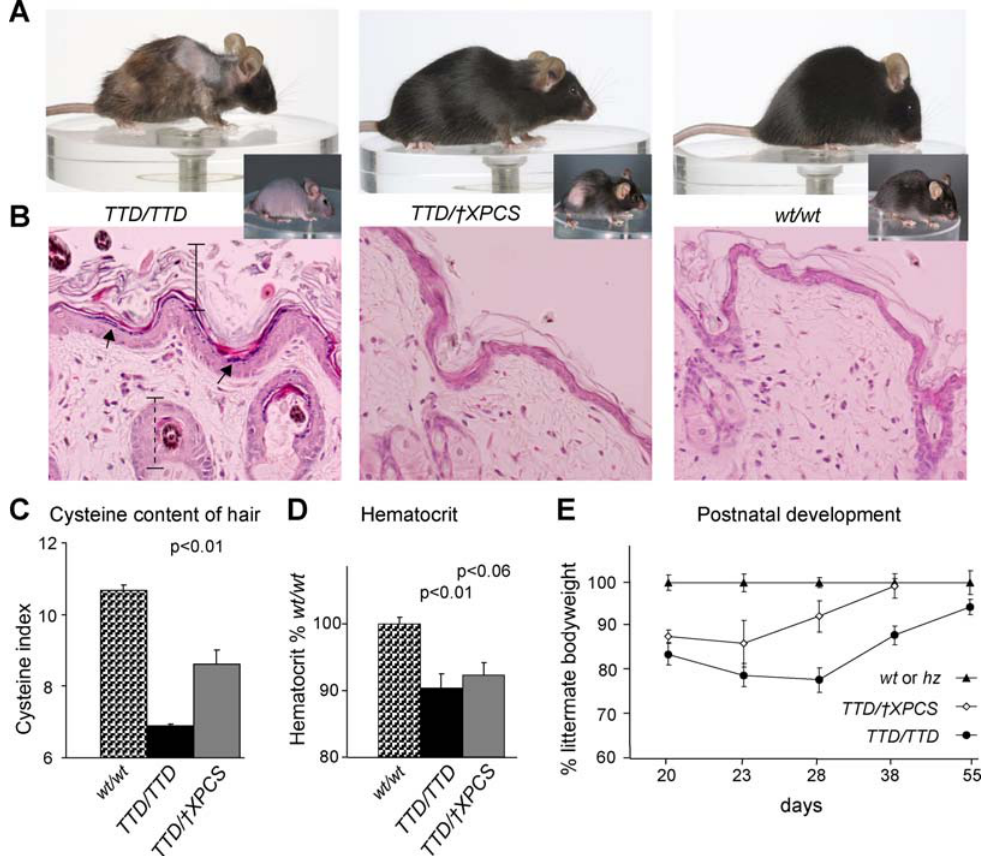
Figure 2. Partial Rescue of TTD Cutaneous, Blood, and Developmental Phenotypes in Compound Heterozygous Xpd TTD/ (cid:1) XPCS Mice (A) Photographs of 5-mo-old homozygous Xpd TTD/TTD , compound heterozygous Xpd TTD/ (cid:1) XPCS, and wt mice. Insets: images of first-round hair loss. (B) Histological analysis of the skin of Xpd TTD/TTD , Xpd TTD/ (cid:1) XPCS, and wt mice. TTD-associated acanthosis (thicker epidermis, indicated by solid vertical line), pronounced granular layer (indicated by arrows), and sebacious gland hyperplasia (indicated by dotted vertical line) were absent in the epidermis of Xpd TTD/ (cid:1) XPCS and wt mice. Magnification 400 3 . (C) Cysteine content of hair from wt, Xpd TTD/TTD , and Xpd TTD/ (cid:1) XPCS mice. The p -value indicates significant differences between mutants and wt, as well as between Xpd TTD/TTD and Xpd TTD/ (cid:1) XPCS mice. Error bars indicate standard error of the mean (SEM). (D) Hematocrit values from blood of Xpd TTD/TTD and Xpd TTD/ (cid:1) XPCS mice. The p -values indicate the significance of the difference relative to wt. Error bars indicate SEM. (E) Body weights of developing Xpd TTD/TTD and Xpd TTD/ (cid:1) XPCS mice after weaning plotted as a percentage of the weight of age-matched control wt and heterozygote (hz) littermates (set at 100%). Error bars indicate SEM. DOI: